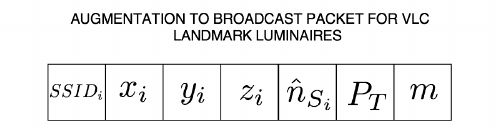
Figure 2. Broadcast VLC